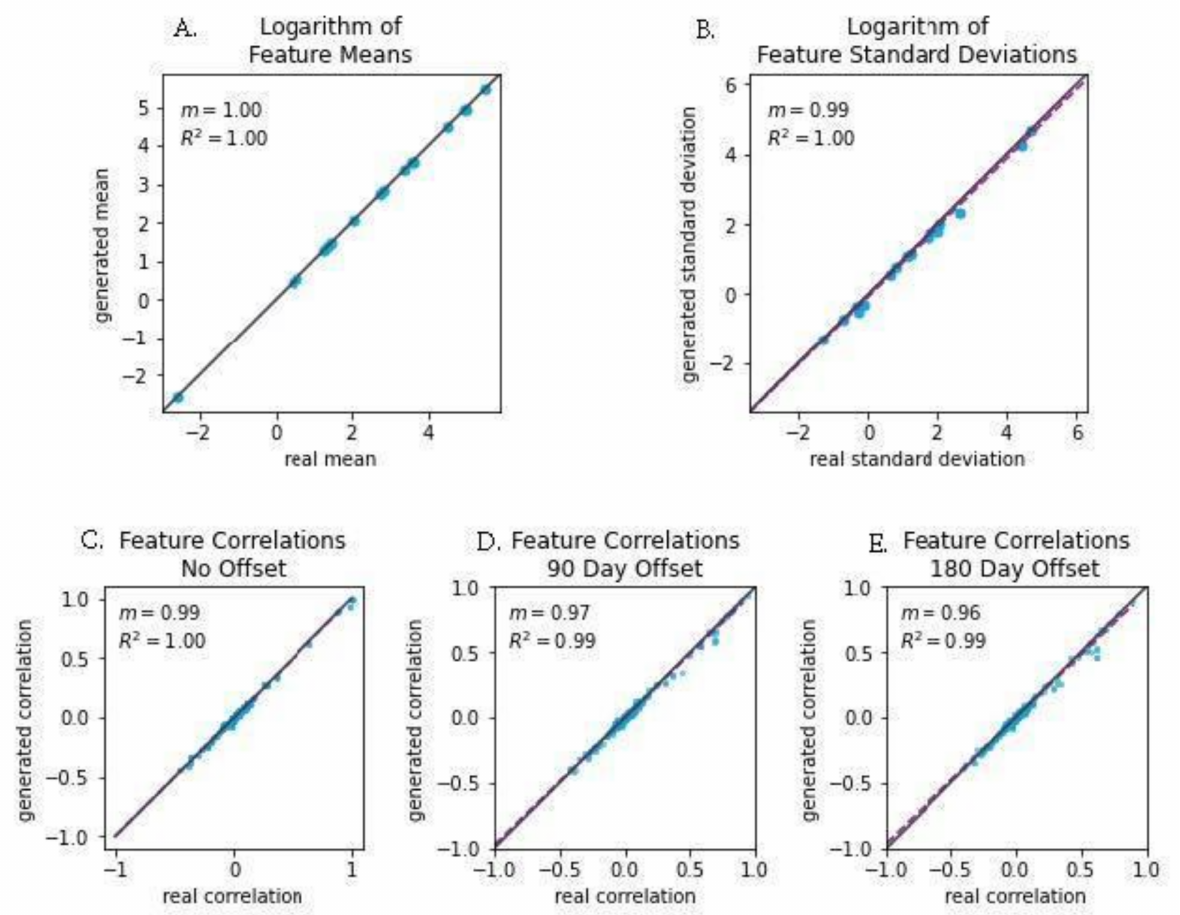
Figure 3. Feature mean correlation plots showing the fidelity of the synthetic data with actual data. Each point represents the standardized features of each synthetic trajectory matched with the actual trajectory. ( A ) Logarithm of Feature Means; ( B ) Logarithm of Feature Standard Deviations; ( C ) Feature Correlations, No Offset; ( D ) Feature Correlations, 90 Day Offset; ( E ) Feature Correlations: 180 Day